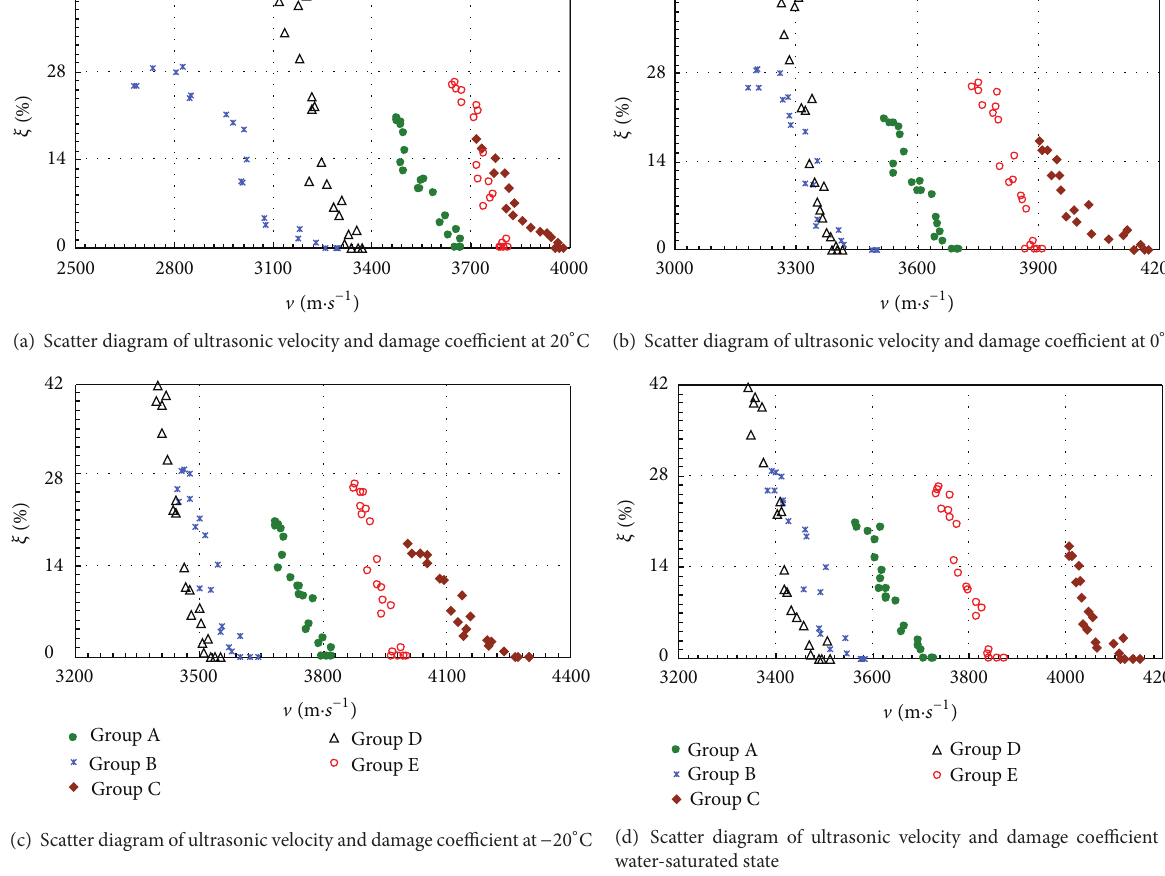
Figure 8: Scatter diagram of ultrasonic velocity and damage